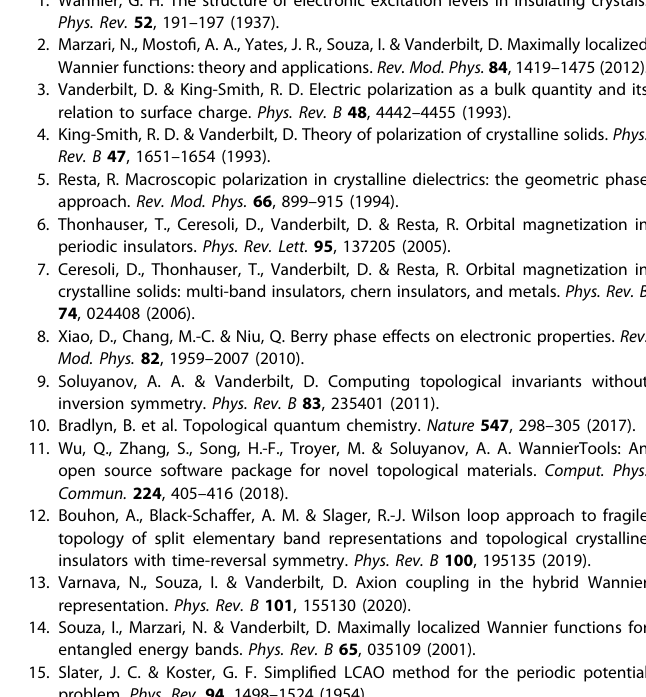
. Curves evaluated F